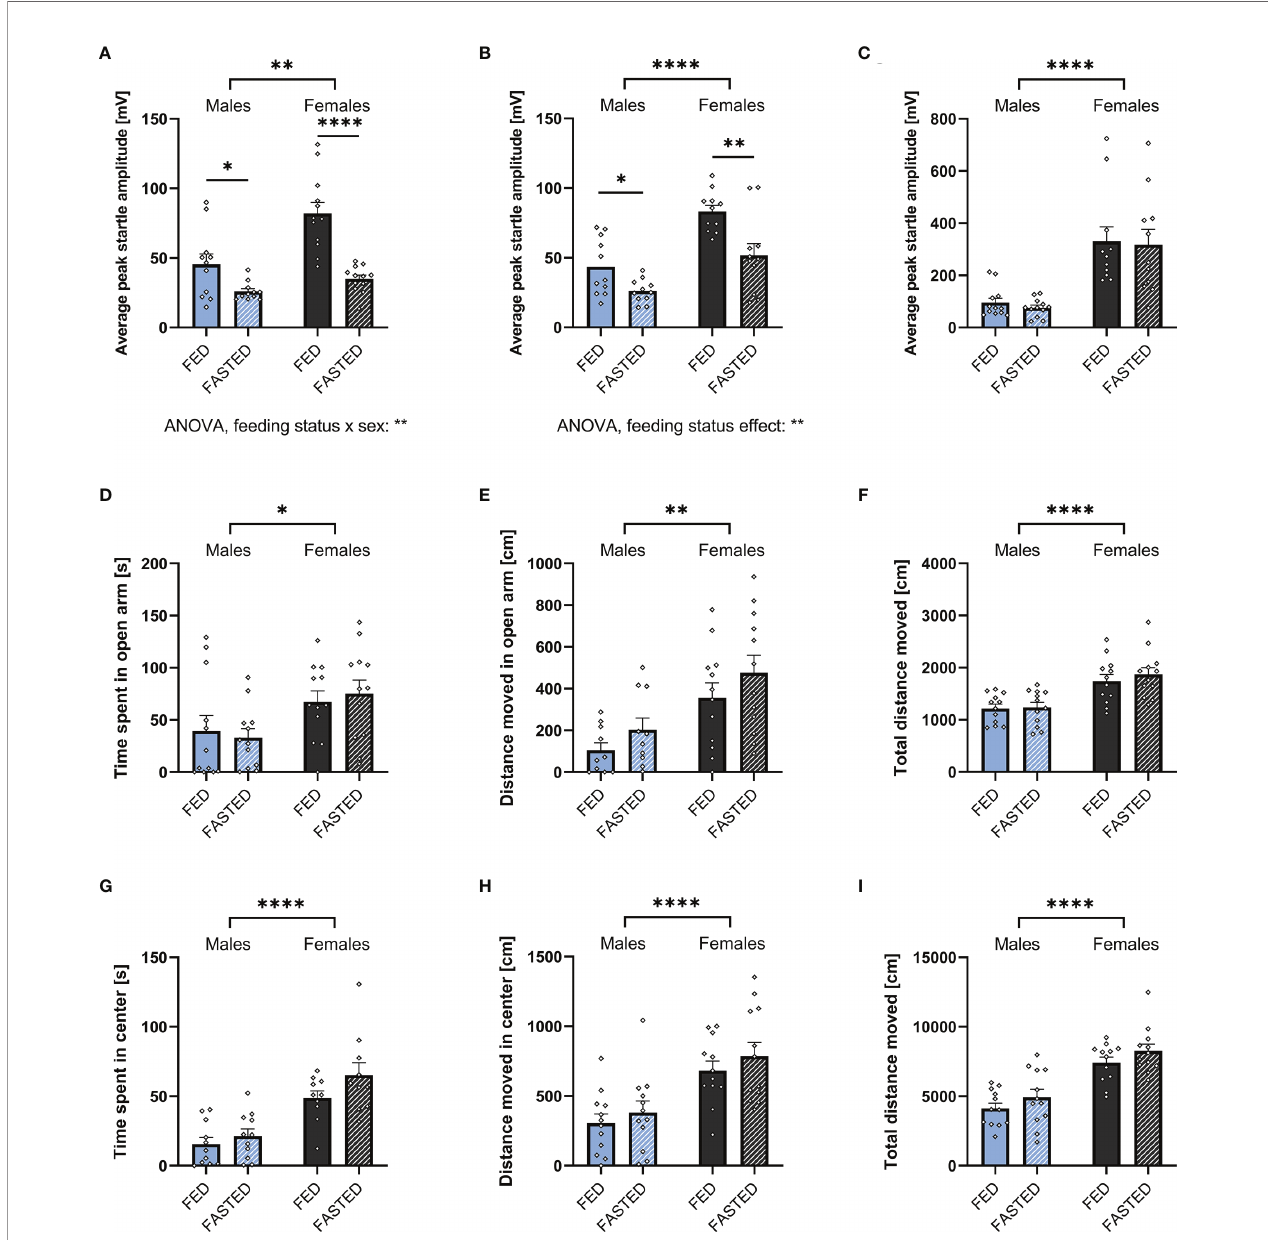
FIGURE 4 | Overnight fasting is anxiolytic in the ASR test. Fasting male and female rats overnight decreased ASR amplitude following a 90 (A) and 95 (B) , but not 105 dB white noise burst (C) . Moreover, it did not have an effect on time spent (D) and distance moved (E) in the open arm, as well as total locomotion (F) in an EPM. Neither did fasting affect time spent (G) and distance moved (H) in the center, or total locomotion in the OF (I) . All data are presented as mean ± SEM. * p < 0.05, ** p < 0.01, **** p < 0.0001 compared with respective controls. n = 12 per treatment group in each sex in the ASR and EPM, and n = 11 per treatment group in the OF respectively. ASR, acoustic startle response; EPM, elevated plus maze; OF, open fi